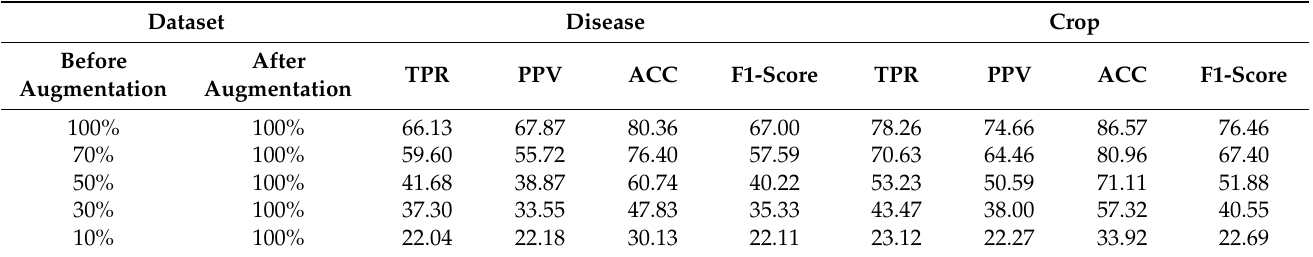
Table 23. Comparison of accuracies achieved by the proposed PI-CNN in the original and augmented datasets. The accuracies were achieved in the PlantDoc dataset (unit: %).